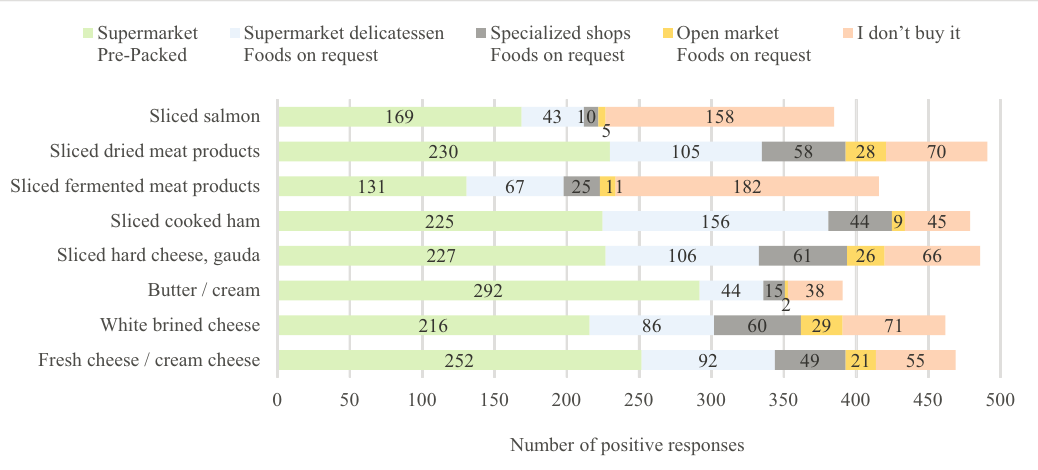
Figure 2: Places where the participants purchase RTE foods. ( The respondents ( N = 350 ) could select more than one option. )